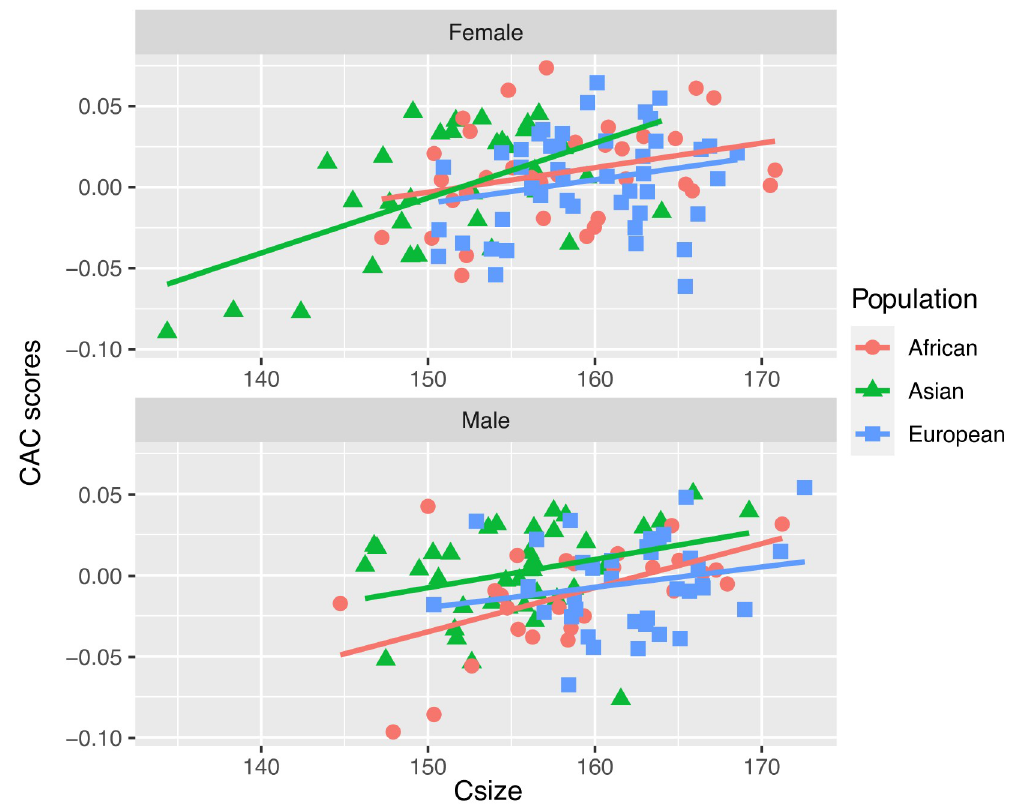
Fig 7. Multivariate regression with Procrustes coordinates and centroid